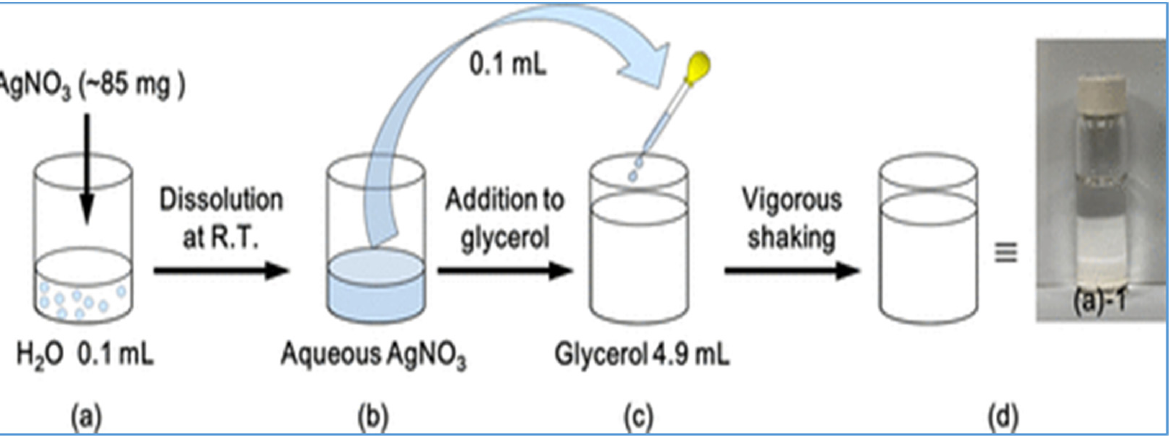
Figure 4. Chemical synthesis of silver nanoparticles with silver nitrate and glycerol under natural conditions [121].